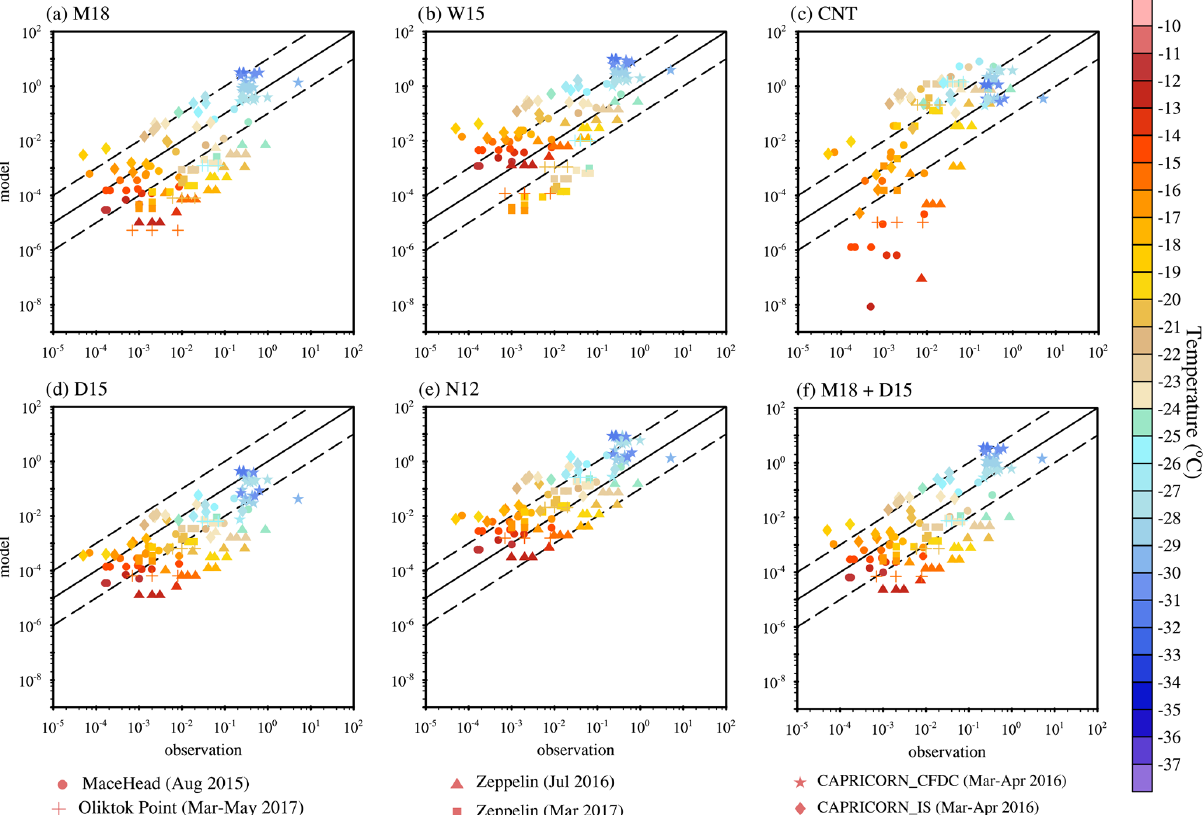
Figure 4. Comparison of simulated versus observed INP number concentrations for different simulations: (a) MOA INPs from M18 (Mc- Cluskey et al., 2018), (b) MOA INPs from W15 (Wilson et al., 2015), (c) dust INPs from CNT (Wang et al., 2014), (d) dust INPs from D15 (DeMott et al., 2015), (e) dust INPs from N12 (Niemand et al., 2012), and (f) the sum of dust and MOA INPs from D15 and M18. Simulated INP data are sampled at the same pressures, longitudes, and latitudes as the field measurements. Dashed lines outline a factor of 10 about the 1:1 line (solid) in all the panels. The color bar shows the observed temperature in degrees Celsius, while different markers represent different field campaigns. The Zeppelin site is located at 78.9081 ◦ N, 11.8814 ◦ E, 475m above mean sea level in Ny Ålesund, Svalbard; the INP data were collected during July 2016 and March 2017 (Tobo et al., 2019). The Oliktok Point site is located at 70.50 ◦ N 149.89 ◦ W; the INP data were collected from March to May 2017 (Creamean et al., 2018). The CAPRICORN (Clouds, Aerosols, Precipitation, Radiation, and Atmospheric Composition over the Southern Ocean) INP data were collected on ships from 13 March to 15 April in 2016 over the Southern Ocean (McCluskey, et al., 2018a). The Mace Head site is located at 53.32 ◦ N, 9.90 ◦ W; the INP data were collected during August 2015 (McCluskey et al.,